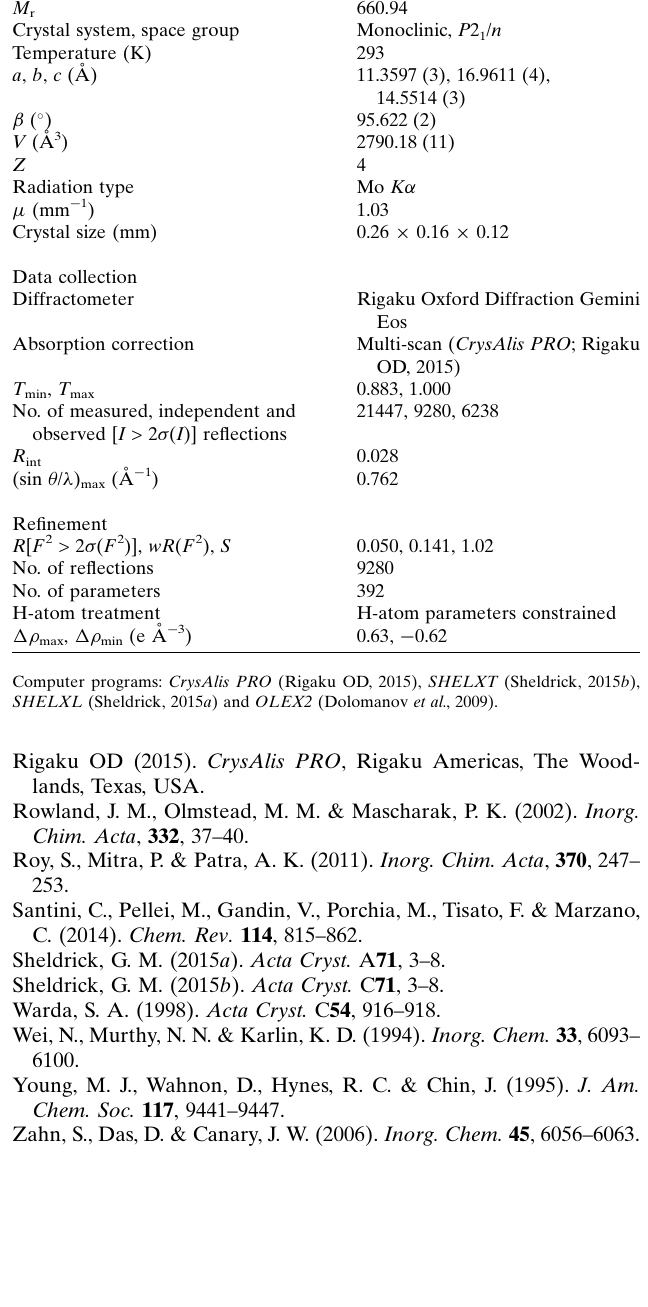
Crystal data Chemical